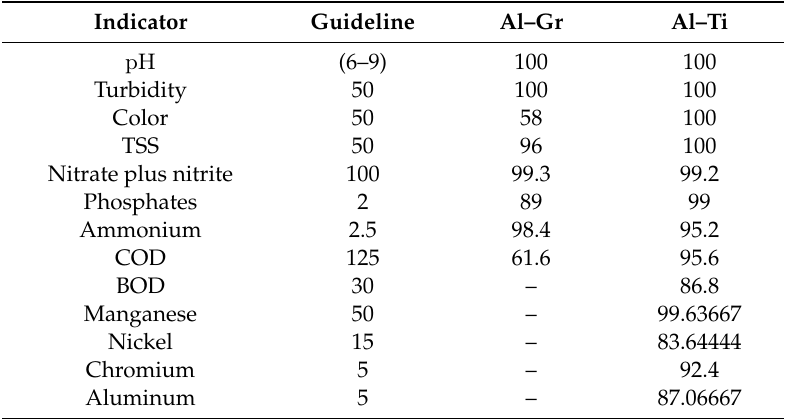
Table 8. Percent compliance based on surface freshwater quality